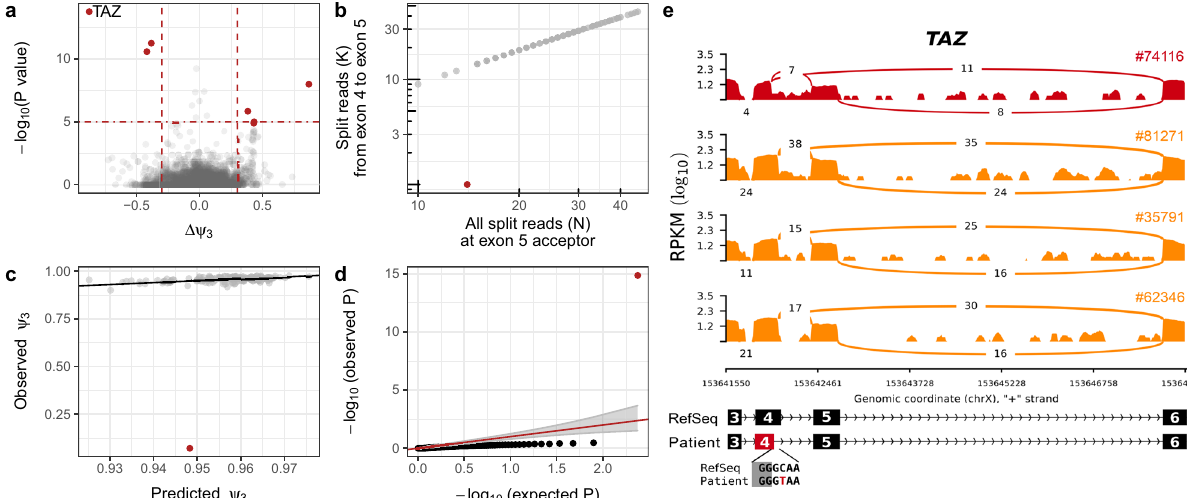
Fig. 7 Detection of a pathogenic splicing defect using FRASER. a Gene-level signi fi cance ( − log 10 ( P ), y -axis) versus effect (observed minus expected ψ 3 , x -axis) for alternative donor usage for individual 74116. Six genes (red dots, including TAZ ) passed both the genome-wide signi fi cance cutoff (horizontal dotted line) and the effect size cutoff (vertical dotted lines). b Number of split reads spanning from the fourth to fi fth exon ( y -axis) against the total number of split reads at the acceptor site of the fi fth exon ( x -axis) of the TAZ gene. Sample 74116 (red) deviates from the cohort trend. c Observed ( y -axis) against FRASER-predicted ( x -axis) ψ 3 values for the data shown in b . d Quantile-quantile plot of observed P values ( − log 10 ( P ), y -axis) against expected P values ( − log 10 ( P ), x -axis) and 95% con fi dence band (gray) for the data shown in b . Sample 74116 (red) shows an unexpectedly low P value. e Sashimi plot of the exon-truncation event in RNA-seq samples of the TAZ -affected (red) and three representative TAZ -unaffected (orange) individuals. The RNA-seq read coverage is given as the log 10 RPKM-value (Reads Per Kilobase of transcript per Million mapped reads, y-axis) and the number of split reads spanning an intron is indicated on the exon-connecting line. e (bottom) the gene model of the RefSeq annotation is depicted in black and the aberrantly spliced exon is colored in red. The insert depicts the donor site-creating variant of the affected individual 74116. a , d P values were calculated two-sided with the beta- binomial distribution, and signi fi cance was determined based on FDR after adjusting for multiple comparisons ( “ Methods ”